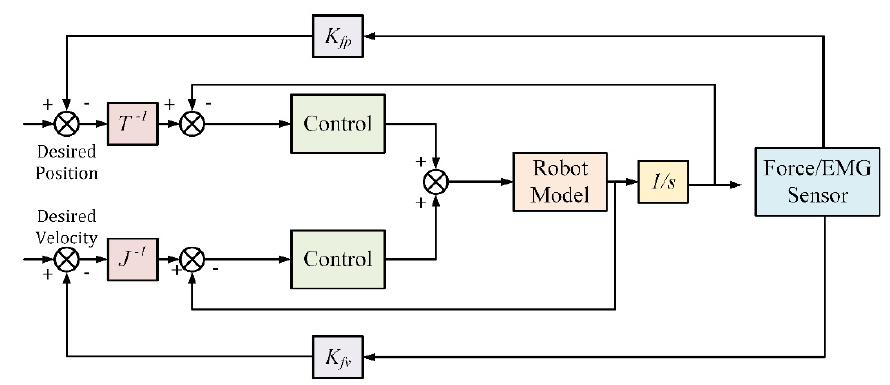
Figure 13. Sample Impedance Control schematic.